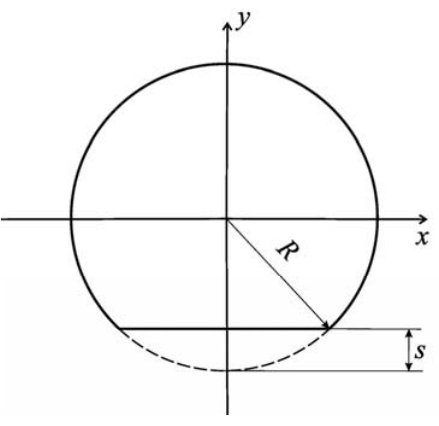
Fig. 1 The displacement of particle